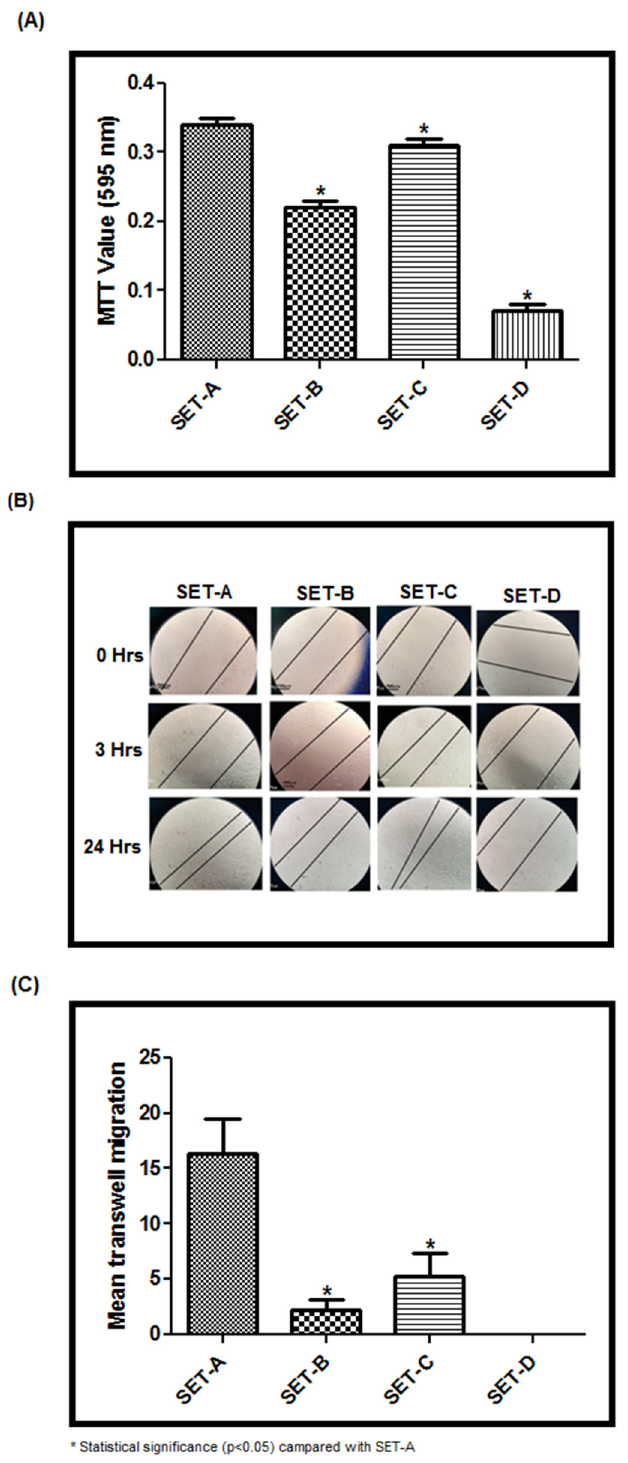
Figure 8. ( A ) MTT assay; ( B ) Scratch wound healing assay; ( C ) Cell migration assay to test bio- compatibility.